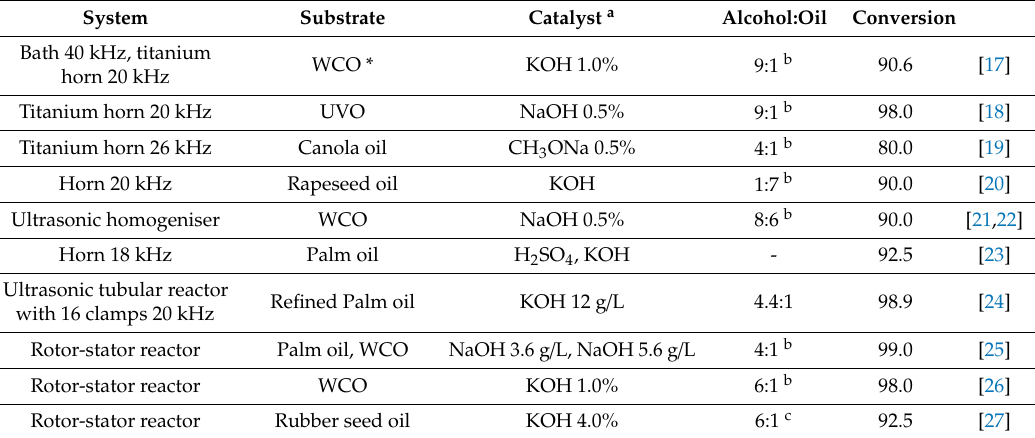
Table 2. US- and HC-assisted processes for biodiesel